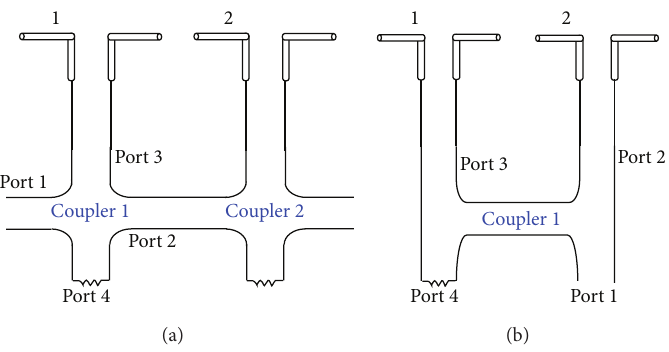
Figure 9: The arrangement of couplers. (a) Series feed network. (b) Parallel feed